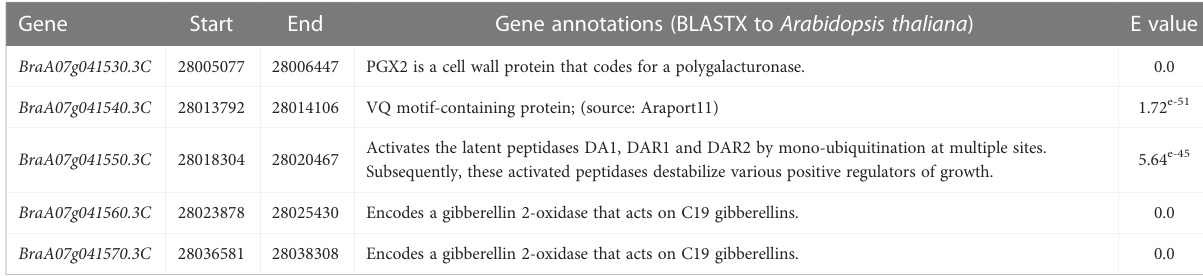
TABLE 1 Annotation of the genes within the mapped region on chromosome A07 in fl owering Chinese cabbage.